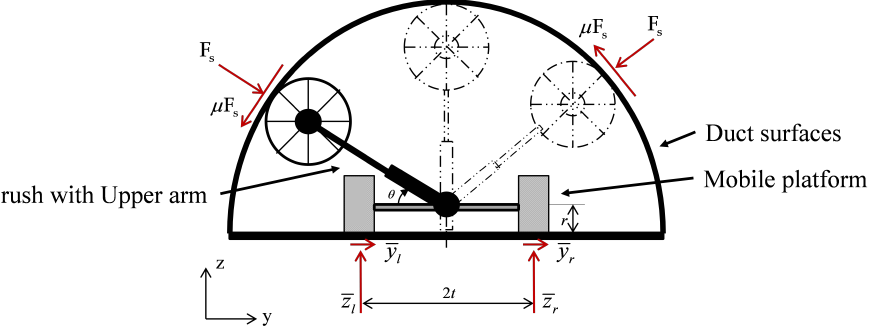
Figure 5. Free body diagram of the cleaning brush inside the circular